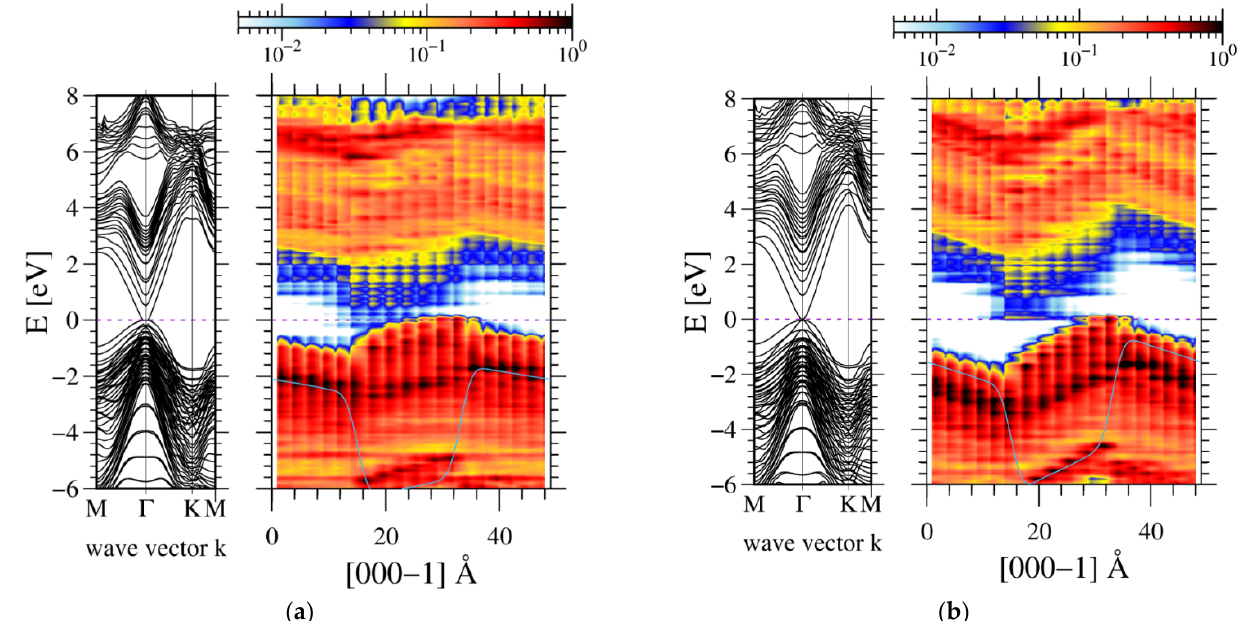
Figure 6. Ab-initio-calculated band profiles, 12GaN-6InN supercell with periodic boundary conditions obtained using PBE ( a ) and GGA-1/2 ( b ) approximations: left panel—momentum space, right panel—real space. The blue line represents electric potential profile presented as electron energy. Freestanding strain state was applied.